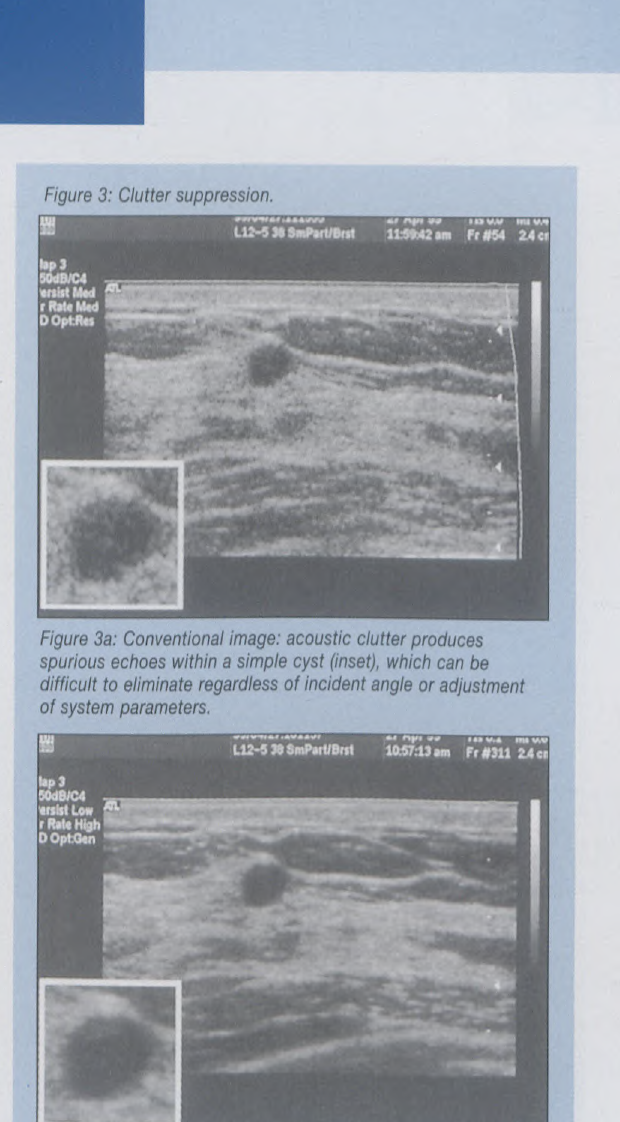
Figure 3b: Compound image: Compound Imaging results in significant clutter suppression in the cyst. Also note the good depth of field in this single focus compound image, comparable to the multi-focus conventional